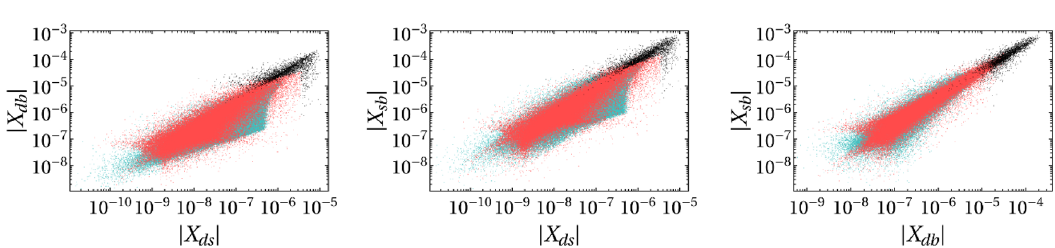
j , for NB-VLQs (red) or generic VLQs ij